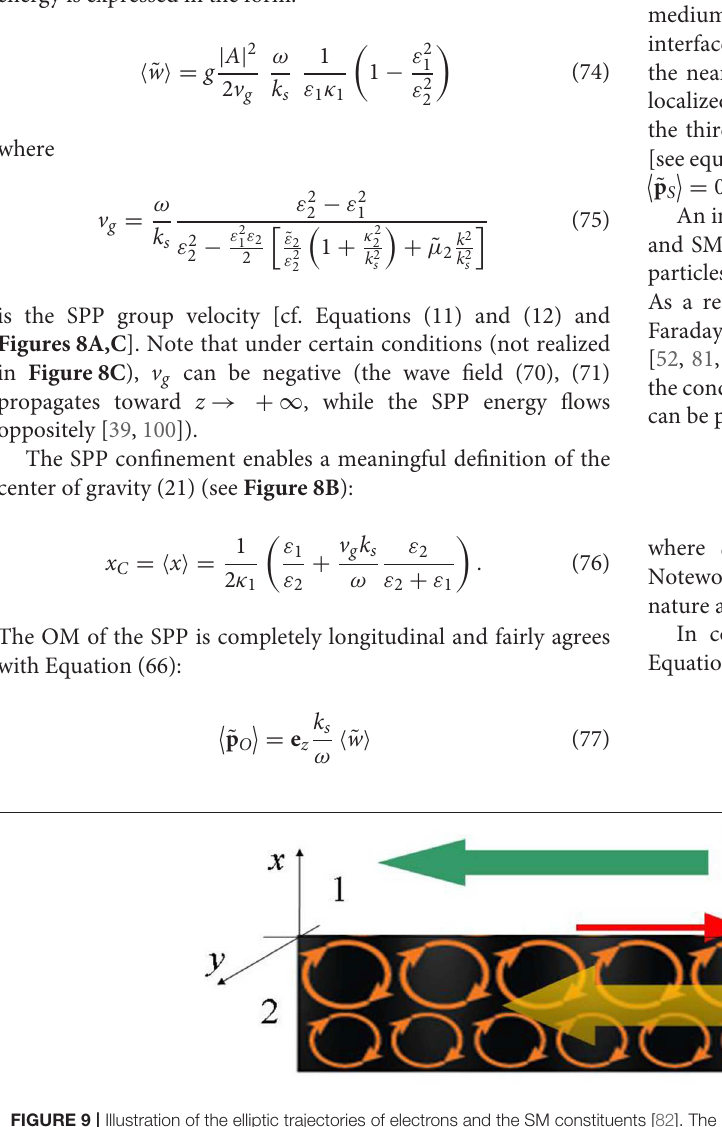
Frontiers in Physics |